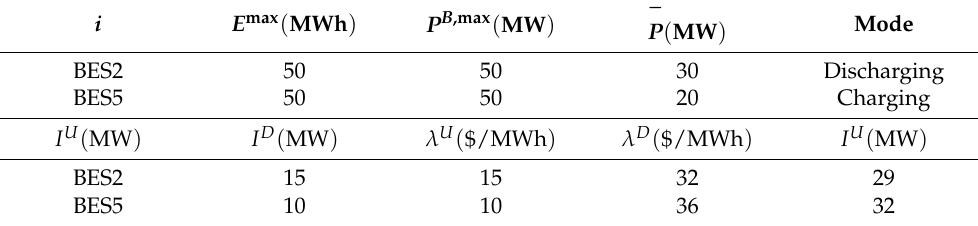
Table 3. Data of